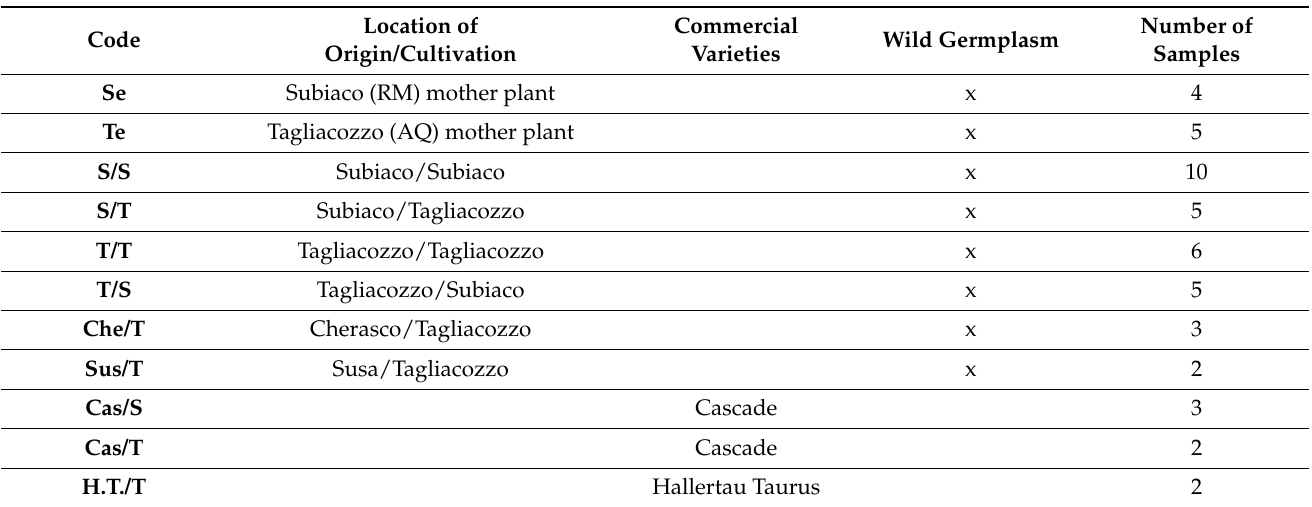
Table 3. Hops germplasm considered in this